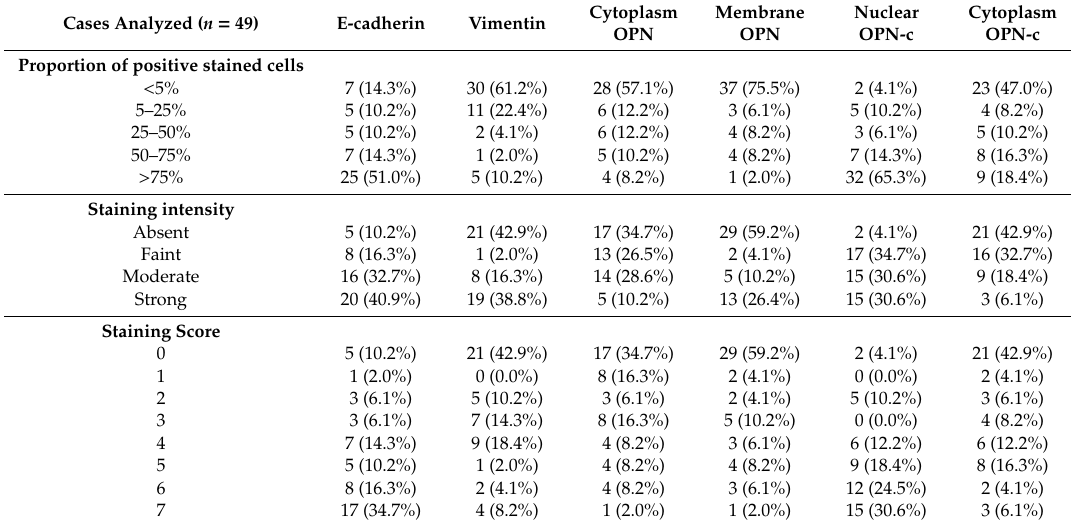
Table 3. IHC staining intensity and proportion of positive stained tumor cells for E-cadherin, vimentin, OPN and OPN-c in OC.